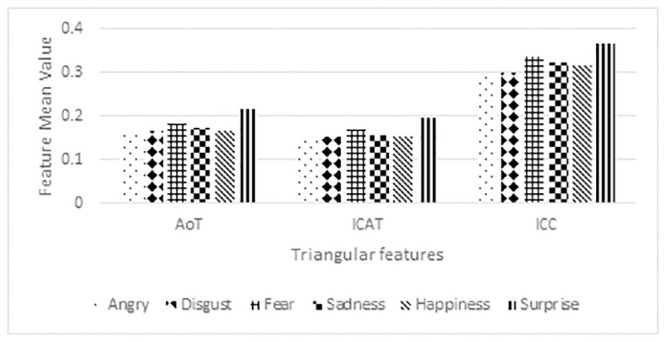
Distribution of the mean value of triangular features in emotion classification.